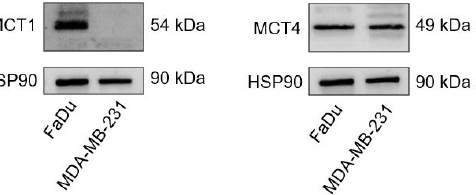
Figure 1. Western blot of MCT1 and MCT4 in FaDu and MDA-MB-231 cells. HSP90 was used as loading control. loading